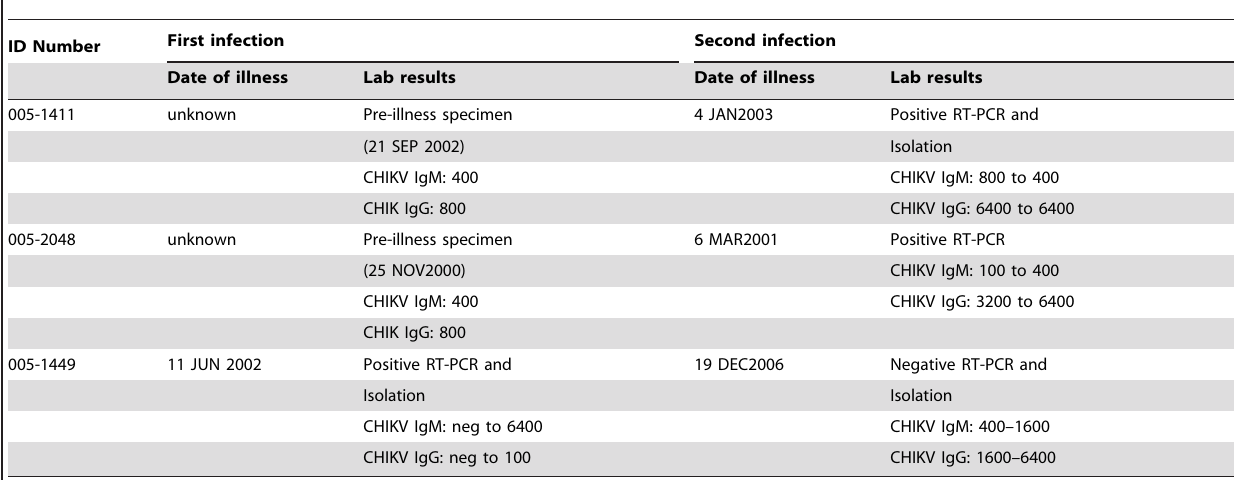
Table 2. Lab results for possible recurrent CHIKV